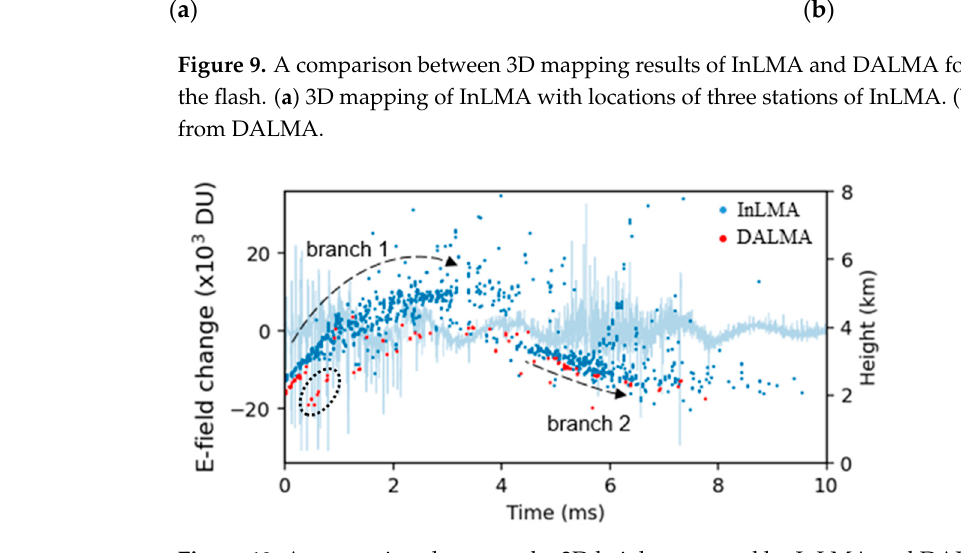
Figure 10. A comparison between the 3D heights mapped by InLMA and DALMA along with the corresponding E-field